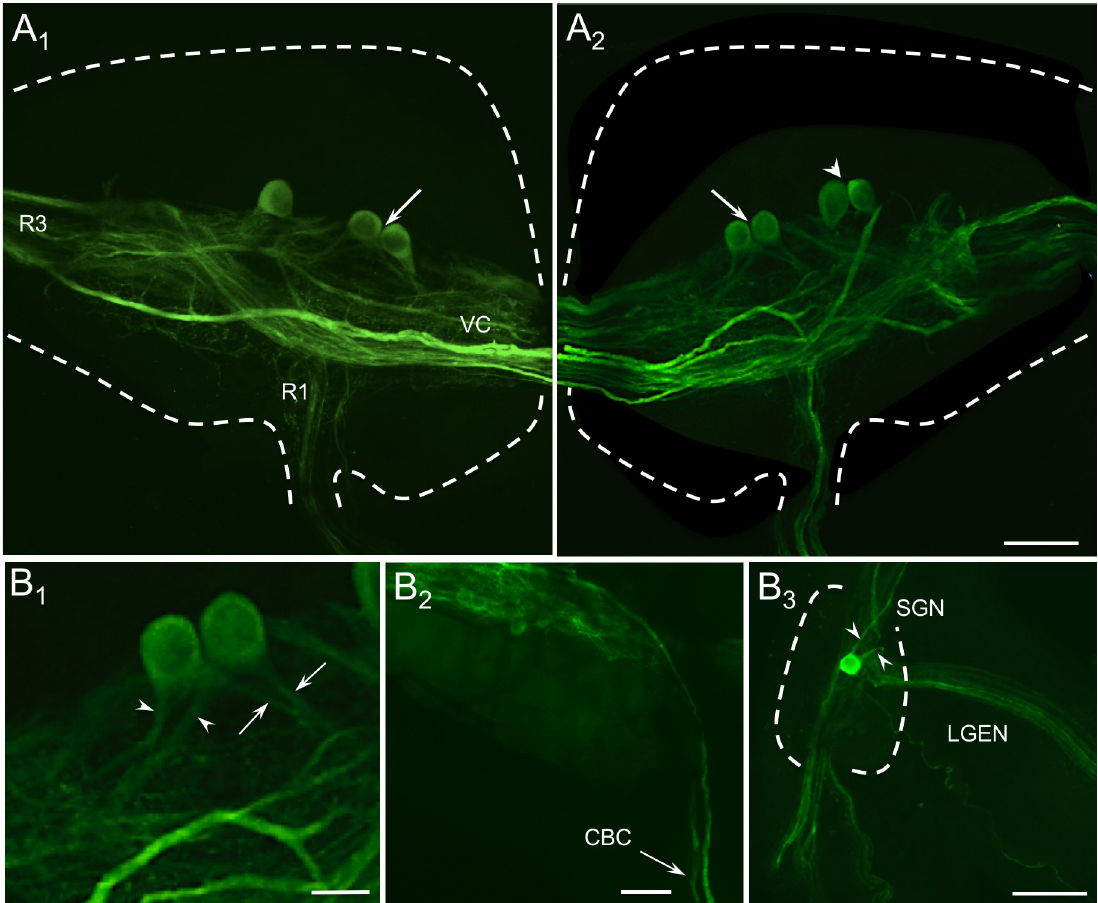
Fig 5. THli in the buccal nervous system. (A 1 ) Ventral view of the right buccal hemiganglion. Outline of the ganglion is marked by the dashed blue line. THli fibers coursed through the ventral commissure (VC) and through the buccal neuropil. The majority crossed the ganglion toward buccal root (R3) but several fibers projected into the first buccal root (R1). Three neurons were stained on the anterior margin of the immunoreactive fiber tract projecting into R3. The two medial neurons were contiguous (arrow). (A 2 ) Ventral view of the left buccal hemiganglion. Four neurons were present in the medial region of the ganglion, including a medial pair (arrow) and a lateral pair (arrowhead). There was no immunoreactivity on the dorsal surface of the ganglion. Calibration bar = 100 μ m, applies to A 1 and A 2 . (B 1 ) Higher magnification of the medial pair of THli cells in the left buccal hemiganglion. Both cells had two fibers originating from the soma, one of which projected medially (arrows) while the other projected laterally (arrowheads). Calibration bar = 40 μ m. (B 2 ) Anterolateral region of left buccal hemiganglion, ventral view. Two stout axons were present in the cerebrobuccal connective (CBC). Calibration bar = 100 μ m. (B 3 ) A single THli neuron was located in the stomatogastric ganglion (STG), which is demarcated by the dashed blue line. Two fibers originated from the cell soma (arrowheads), one projecting toward the periphery via the lateral gastroesophegeal nerve (LGEN) and the other toward the CNS via the stomatogastric nerve (SGN). Calibration bar = 100 μ